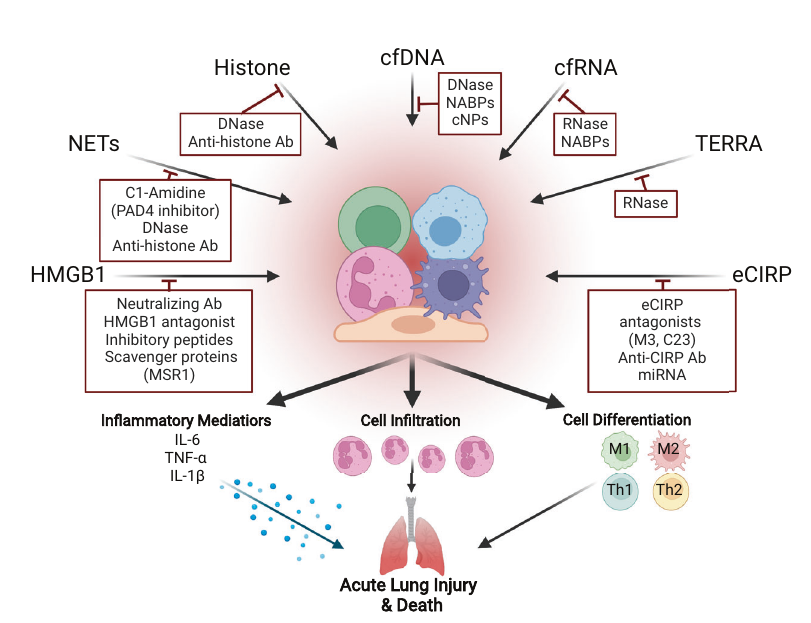
Fig. 2 Targeting CAMPs to attenuate in fl ammation and acute lung injury (ALI) in sepsis. Several inhibitors, i.e., neutralizing antibodies targeting CAMPs or their receptors, small molecule inhibitors, like C23 and M3, CI-Amidine, endogenous inhibitor like miRNAs, RNases, DNase, scavenging molecules, i.e., cNP, NABPs, MSR1 have been discovered to counteract CAMPs, thereby inhibiting the release of in fl ammatory mediators, cellular in fi ltrations, and differentiation and inhibit the development of ALI in sepsis. cfDNA Cell-free DNA, TERRA Telomeric repeat- containing RNA, eCIRP Extracellular CIRP, cNP Cationic nanoparticles, NABPs Nucleic acid-binding polymers, MSR1 Macrophage scavenger receptor